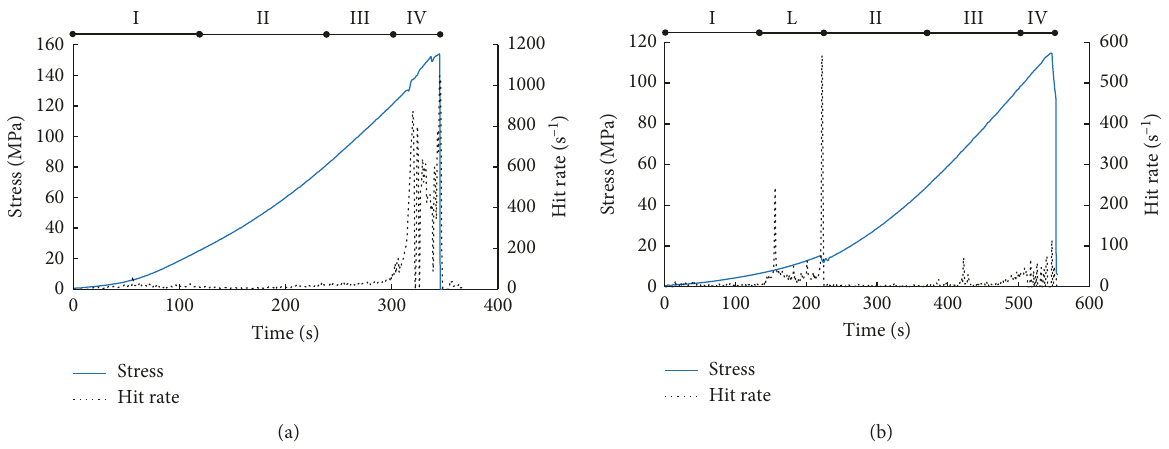
Figure 2: Changes of stress and AE hit rate with time: (a) Sim2; (b) Sim10.